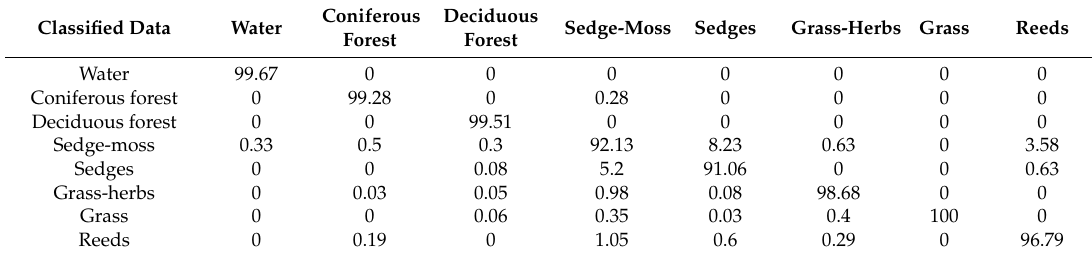
Table 2. Error matrix for classified data in %.